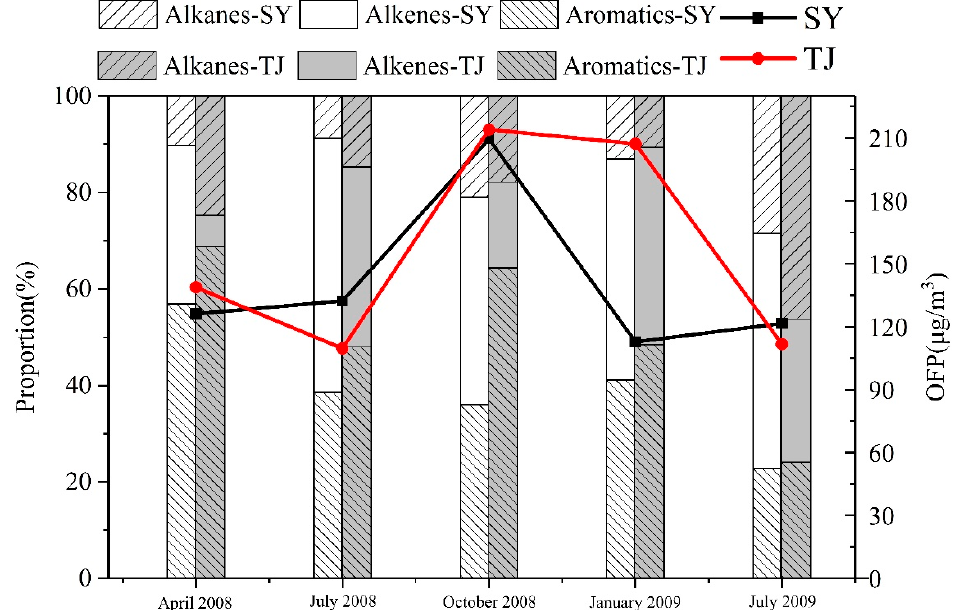
Figure 5. Seasonal variation of contributions to OFP by different VOC groups (alkanes, alkenes and aromatics) at Shenyang and Tianjin. SY: Shenyang, TJ: Tianjin.